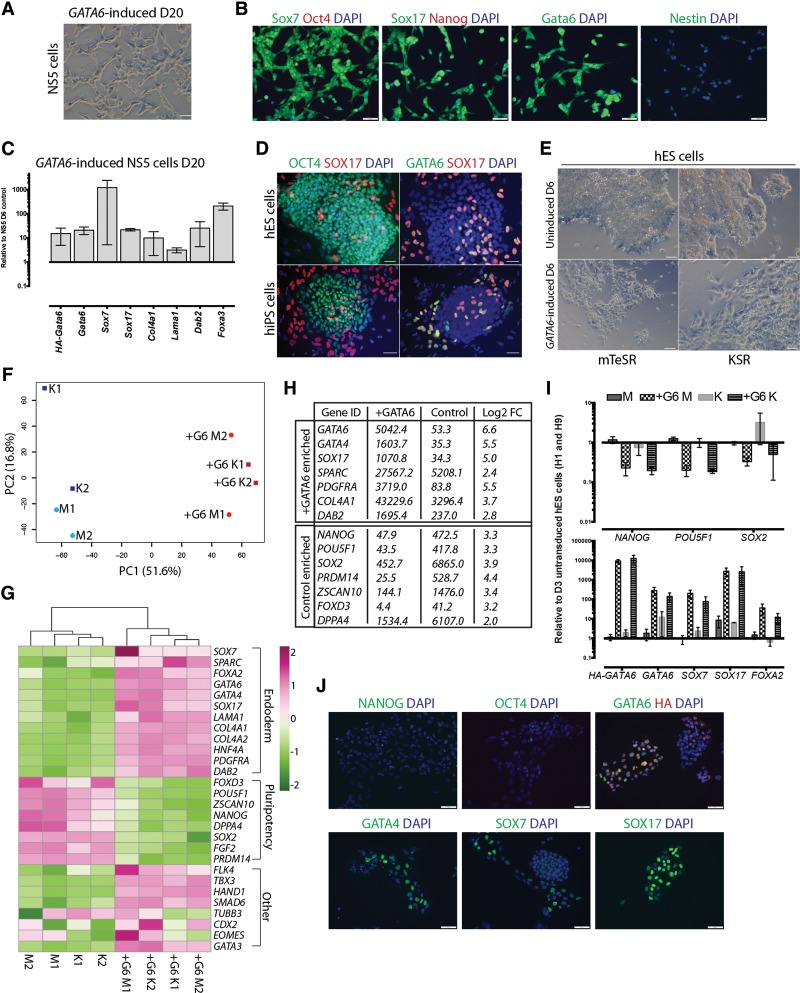
Gata6 initiates an ExEn program in mouse neural stem cells and hES cells. (A) Phase-contrast images of uninduced or GATA6-induced mouse neural stem cells. Bars, 50 μm. (B) Immunofluorescence analysis for Sox7, Sox17, Gata6, or Nestin (green) and Oct4 or Nanog (red) with DAPI (blue) merge in GATA6-induced mouse neural stem cells after 20 d of induction. Bars, 50 μm. (C) qRT –PCR analysis of mouse neural stem cells for HA-tagged exogenous GATA6 and selected endoderm transcripts (Gata6, Sox7, Sox17, Col4a1, Lama1, Dab2, and Foxa3) 20 d following transduction. Data are mean ± SEM of two replicates. (D) Immunofluorescence analysis for OCT4 or GATA6 (green) and SOX17 (red) with DAPI (blue) merge in hES and human iPS (hiPS) cells in pluripotent culture conditions. Bars, 50 μm. (E) Representative phase-contrast images of GATA6-transduced hES cells 6 d after GATA6 induction compared with uninduced controls in pluripotency (mTeSR) or differentiation (KSR) medium. Bars, 50 μm. (F) Principal component analysis using RPKM (reads per kilobase per million mapped reads)-normalized RNA sequencing (RNA-seq) data from biological replicates of uninduced and GATA6-induced (+G) cells in KSR (K) or mTeSR (M) medium. (G) Heat maps showing the hierarchical clustering of uninduced and GATA6-induced (+G) cells in KSR (K) or mTeSR (M) medium using RPKM-normalized RNA-seq data. Expression levels plotted on a high-to-low scale (purple–white–green). (H) DESeq analysis indicating genes significantly differentially expressed in the uninduced control versus GATA6-induced cells in both the KSR and mTeSR conditions. The median gene expression and log2 fold change (FC) difference in expression are noted. (I) qRT –PCR analysis of H1 and H9 hES cells for HA-tagged exogenous GATA6 expression and selected pluripotency (POU5F1, NANOG, and SOX2) and endoderm (GATA6, SOX7, SOX17, and FOXA2) transcripts 6 d following transduction. Data are mean ± SEM of two to three replicates. (J) Immunofluorescence analysis of OCT4, NANOG, GATA4, SOX17, SOX17, and GATA6 (all green) and HA (red) with DAPI (blue) merge in GATA6-induced H9 hES cells 5 d following doxycycline treatment. Bars, 50 μm.